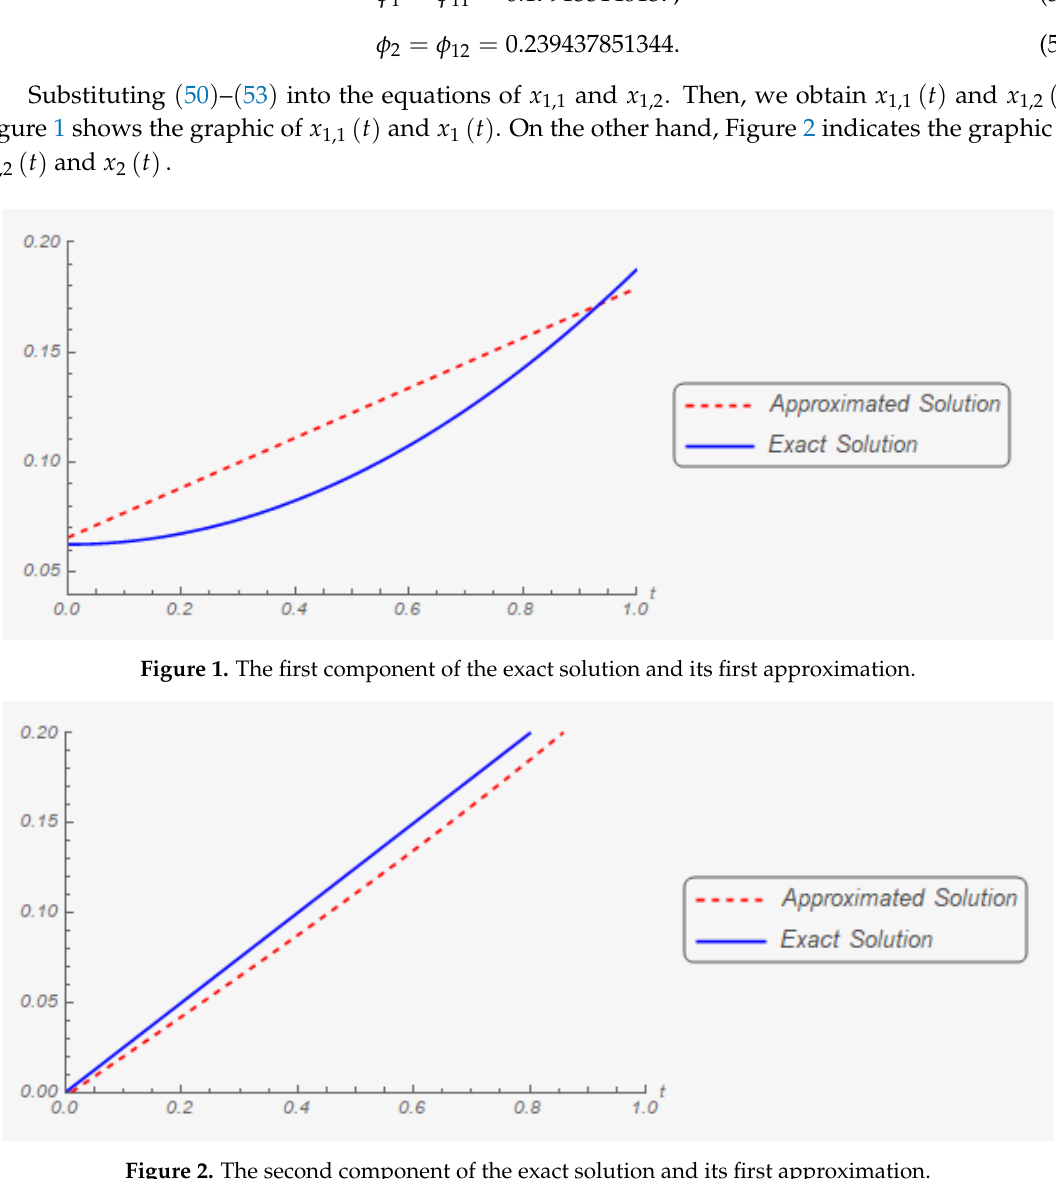
Figure 2. The second component of the exact solution and its first